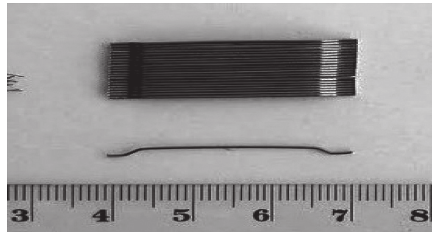
Figure 2: Steel fiber with hooked